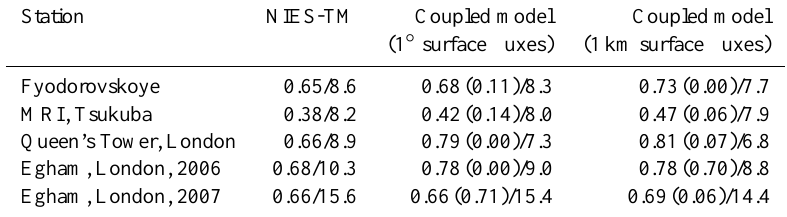
Table 3. Information on correlation coefficients (statistical significance between correlation coefficients (for 1 ◦ : comparison between NIES- TM and 1 ◦ ; for 1km: comparison between 1 ◦ and 1km) and two-tailed p-value between current and previous (from the cell to the left of the current cell in table) correlation coefficients)/centred root-mean-square difference between simulations and observations.